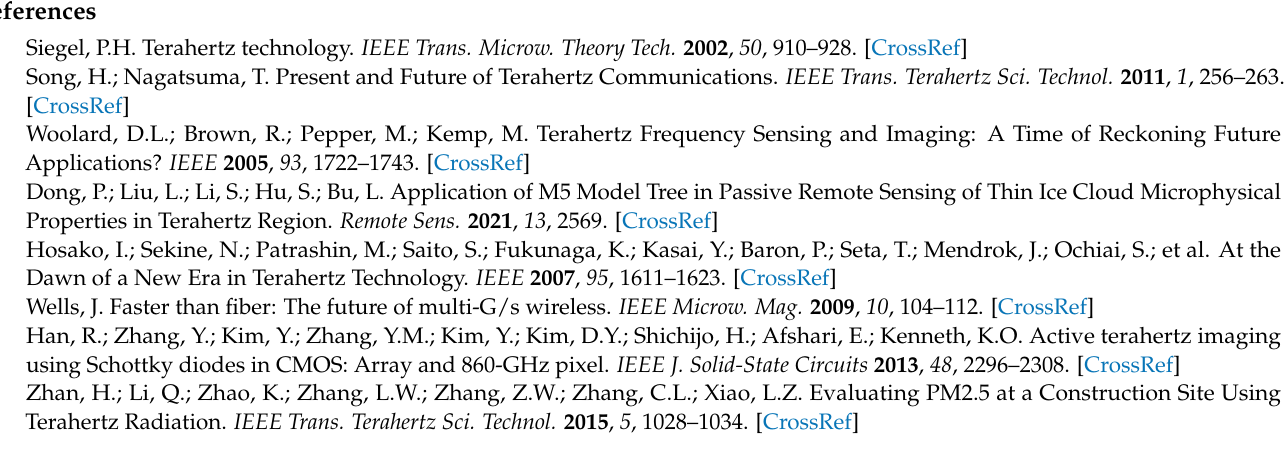
Figure 23. Imaging results of the 220 GHz terahertz front end for a 5 m stand-off distance.